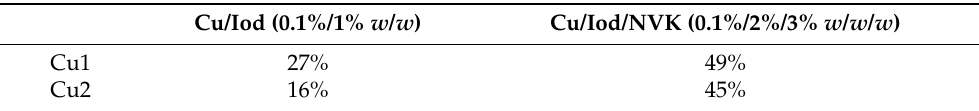
Figure 6. ( A ) Cationic polymerization (CP) profiles of epoxy functions (thin sample) vs. irradiation time upon exposure to LED at 405 nm: (1) Cu1/Iod (0.1%/1% w / w ), (2) Cu2/Iod (0.1%/1% w / w ), (3) Cu1/Iod/NVK (0.1%/2%/3% w / w / w ) and (4) Cu2/Iod/NVK (0.1%/2%/3% w / w / w ). ( B ) IR spectra recorded before and after polymerization. Irradiation starts at t = 10 s. Table 3. Final reactive function conversions for EPOX monomer using two and three-component PISs upon irradiation at 405 nm during the polymerization of thin samples.